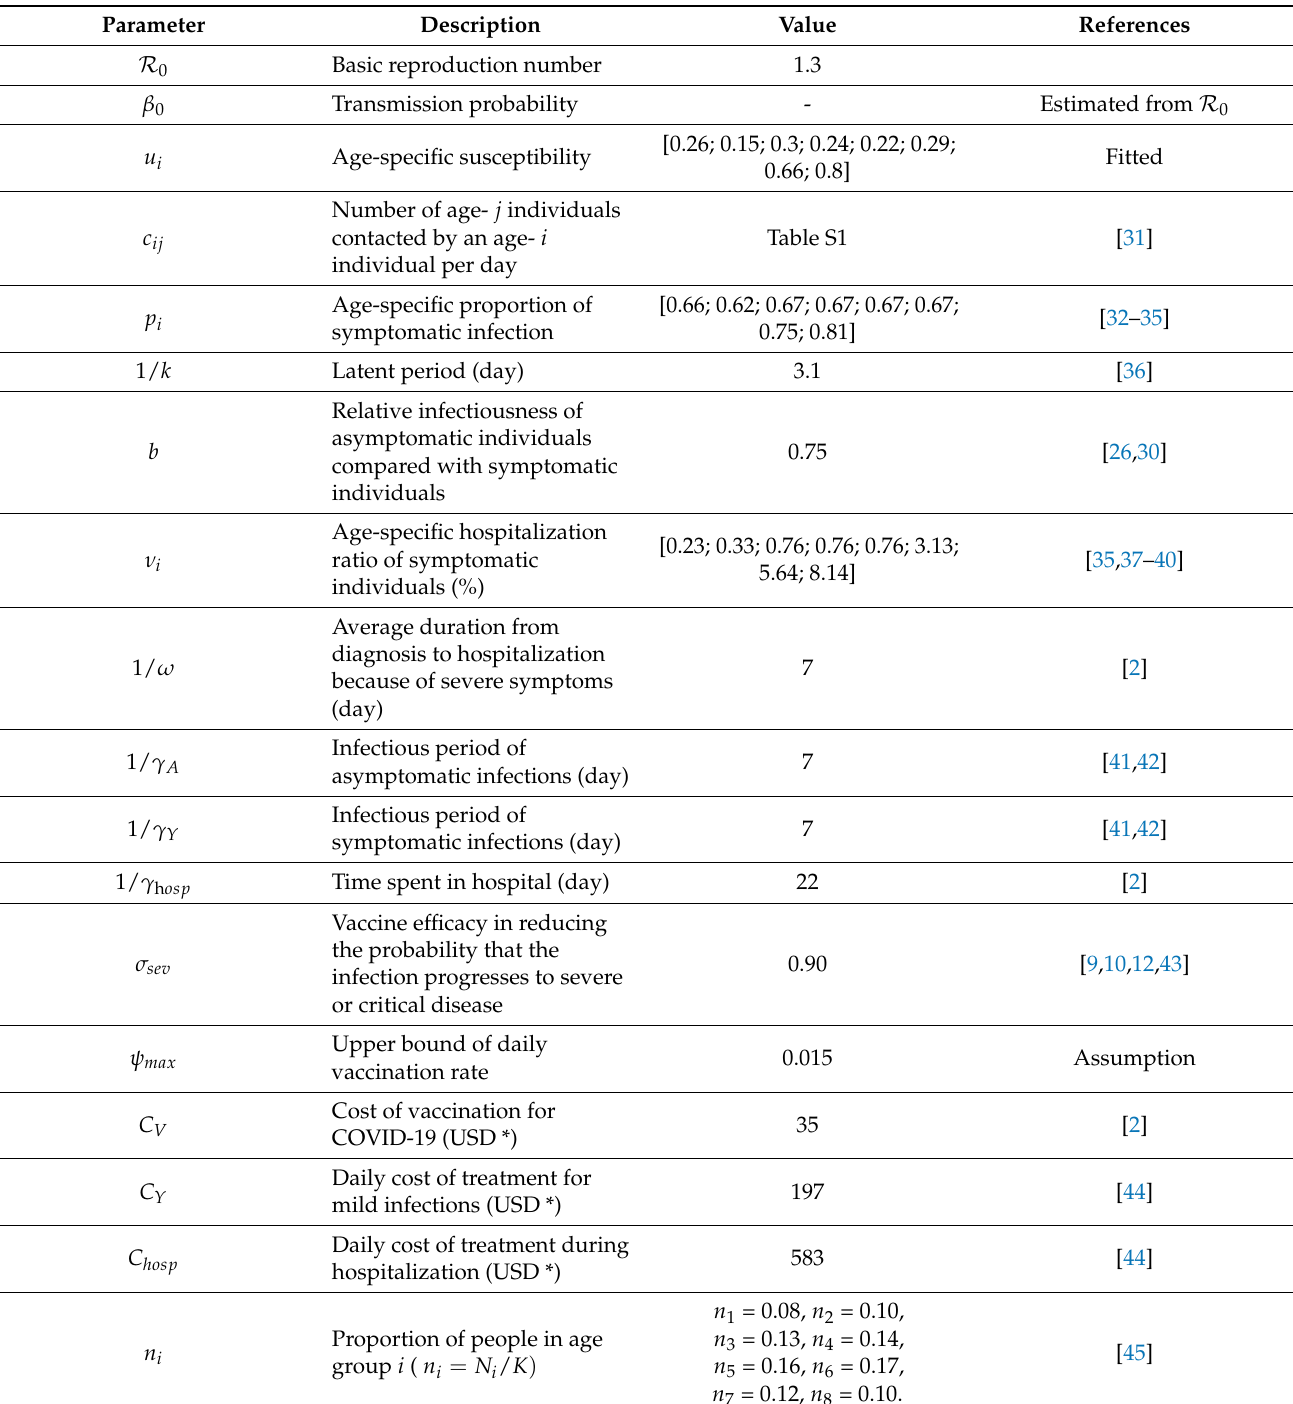
Table 2. Baseline parameter values and description. (* 1 USD = 1114 WON, as of April 16, 2021).